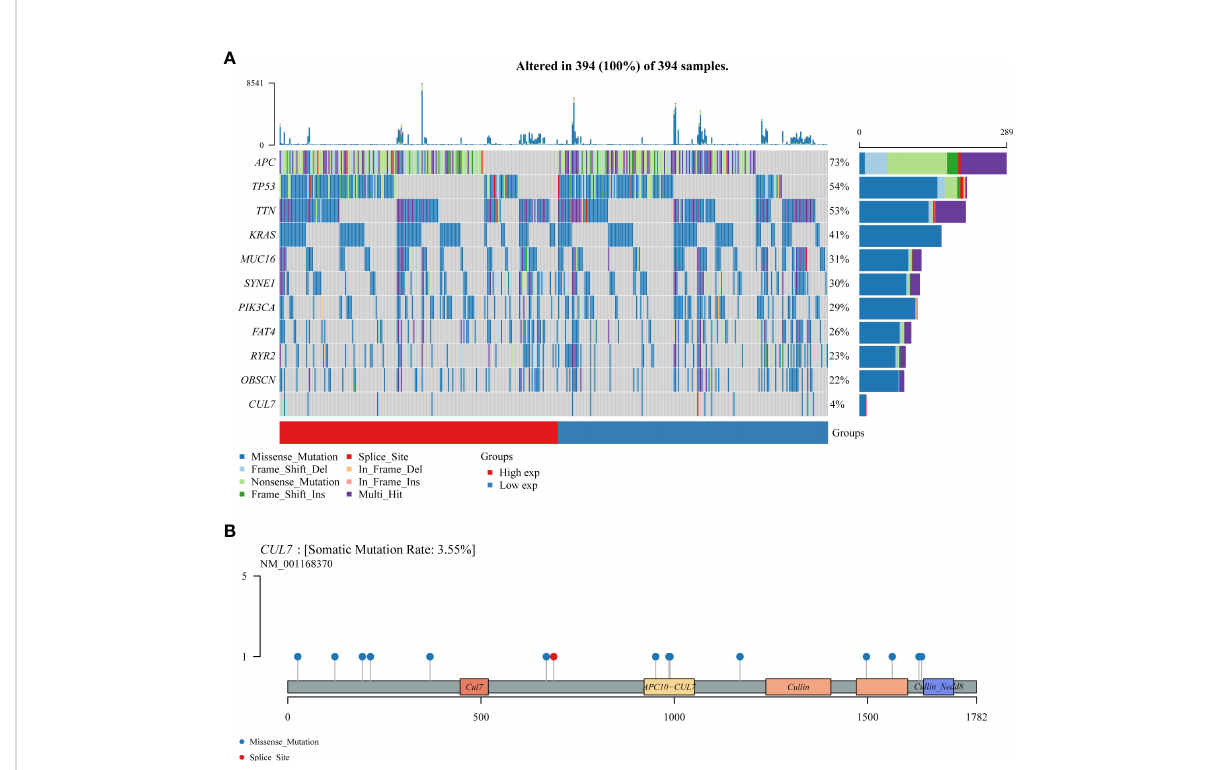
FIGURE 6 The somatic mutation landscape of CUL in COAD. (A) Oncoplot showing the somatic landscape of the COAD tumor cohort. Genes are sorted according to mutation frequency. (B) CUL7 gene mutation distribution